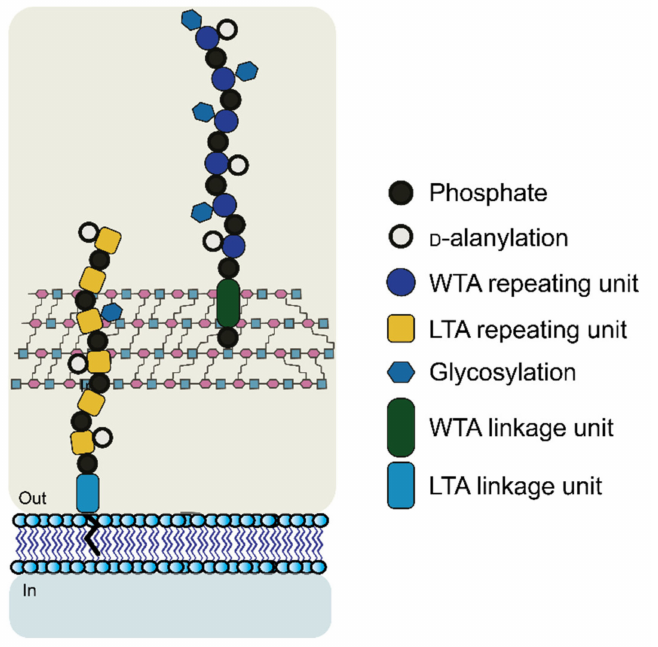
Figure 5. Schematic representation of LTA and WTA in the gram-positive cell wall. The WTA extends beyond the PG layer while LTA may not be able to become elongated past